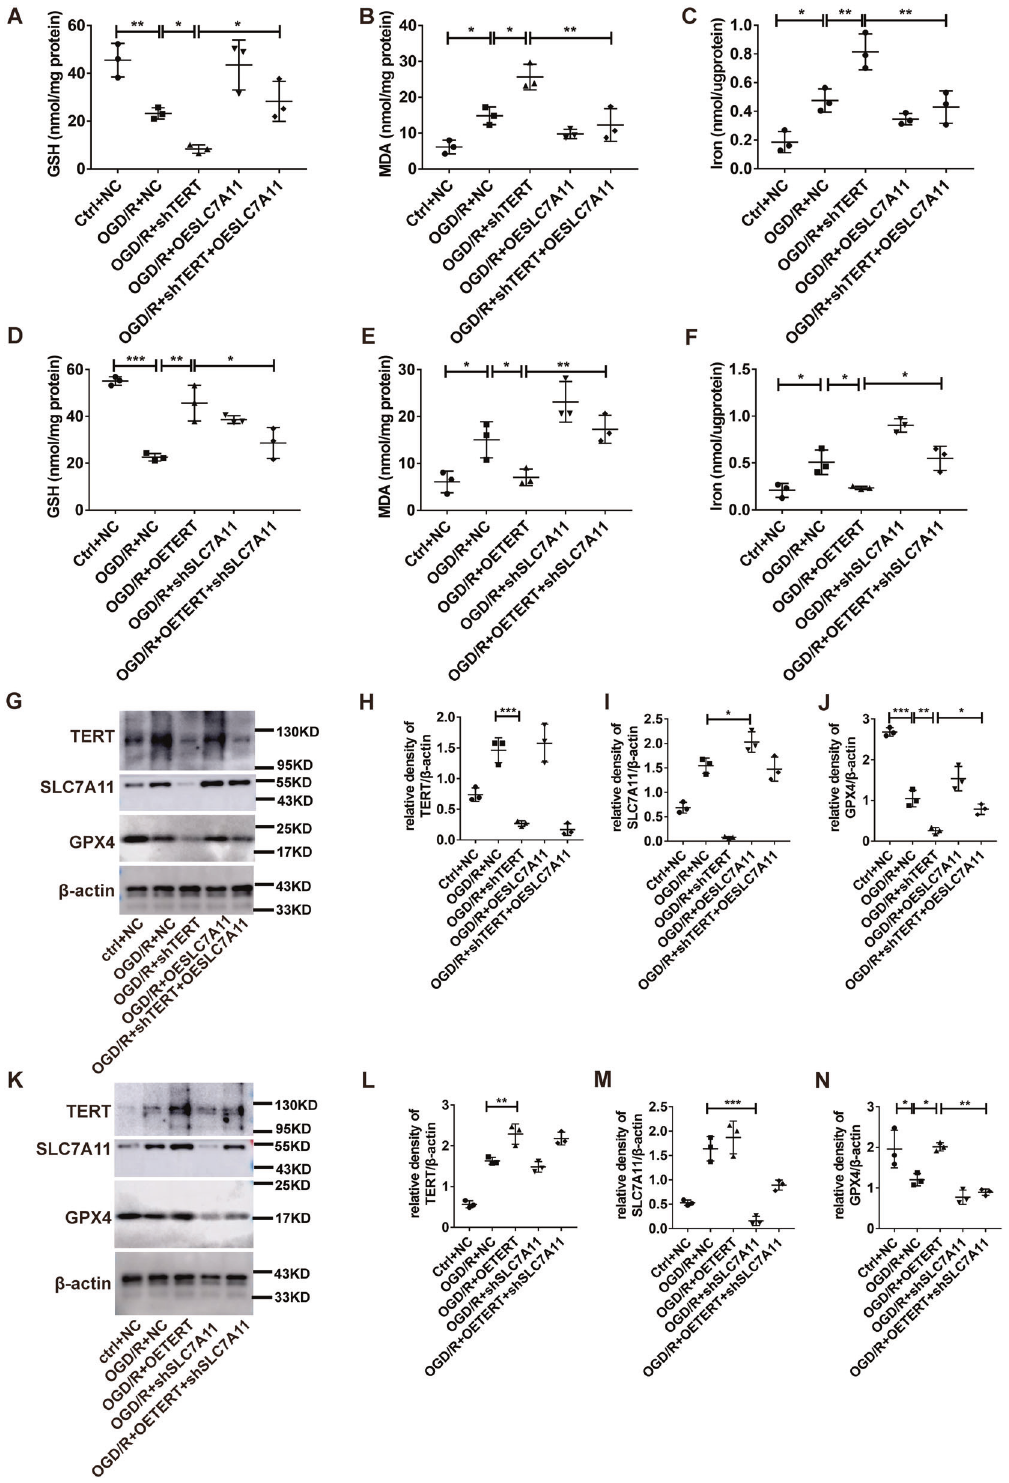
Fig. 7 TERT inhibited ferroptosis-dependent OGD/R injury by facilitated SLC7A11 expression in vitro. A, D GSH levels after OGD/R, as assessed by GSH assay. B , E MDA levels after OGD/R, as assessed by MDA assay. C , F Endogenous Fe levels within pulmonary epithelial cells in the OGD/R model, as detected by Fe assay. G , K Evaluation of TERT, SLC7A11, and GPX4 protein expression via western blotting under different treatment conditions. H – J , L – N Protein quanti fi cation. Data are expressed as mean ± SEM. * P < 0.05, ** P < 0.01, *** P < 0.001 denotes intergroup signi fi cant